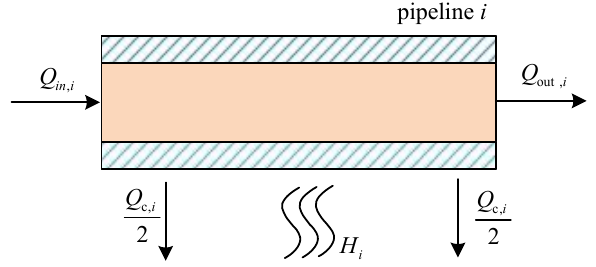
Figure 2. The pipeline mass flow model.